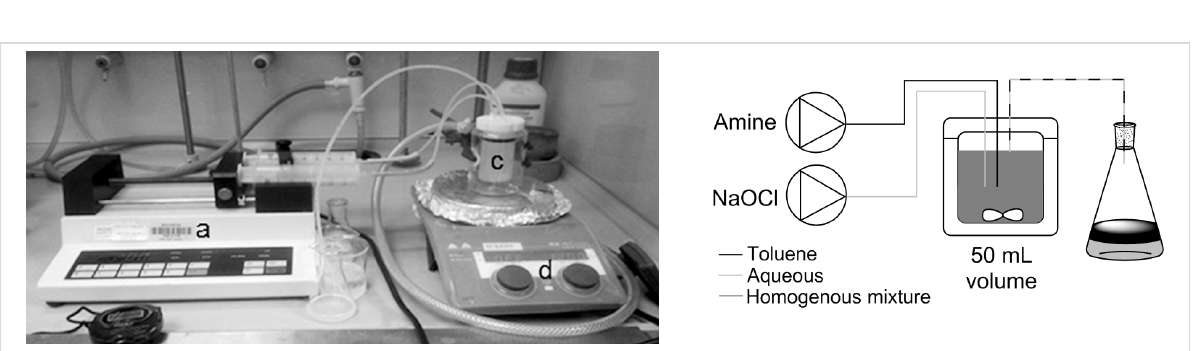
Figure 5: CSTR set-up for N -chloramine formation. (a) Syringe pump, (b) collection vessels, (c) reactor (50 mL), (d) stirrer plate: stirring rate 1200 rpm.